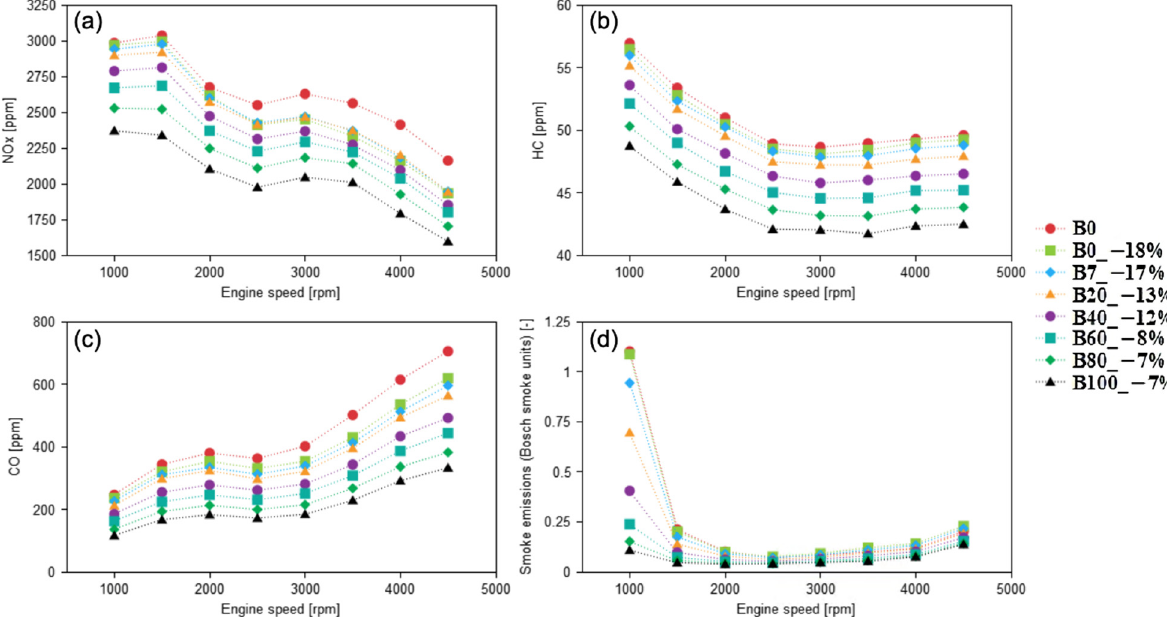
Figure 12. Comparison of emissions ( a ) 𝑁𝑂 𝑥 , ( b ) 𝐻𝐶 , ( c ) 𝐶𝑂 , and ( d ) soot, for different optimal set- ups.